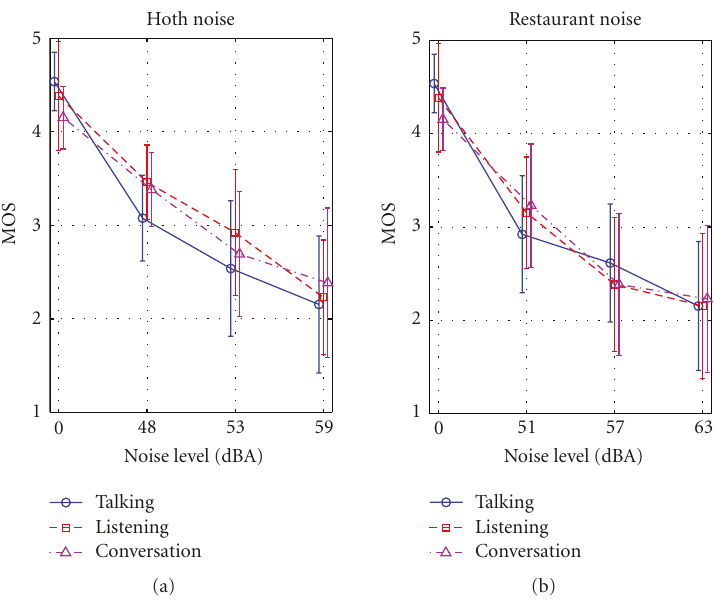
Figure 7: Noise test results.